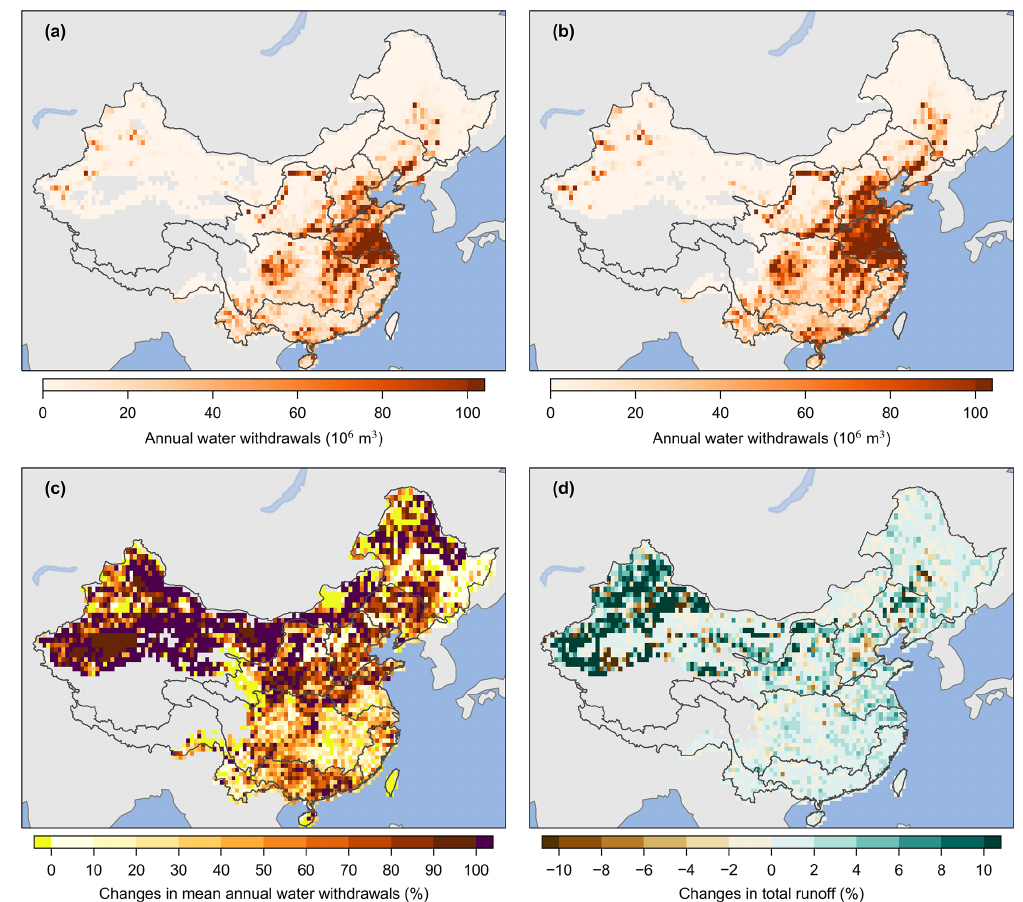
Figure 7. Changes in water withdrawals and total runoff between the two sub-periods. (a) Ensemble medians of mean annual water with- drawals over the 1971–1990 period. (b) Ensemble medians of mean annual water withdrawals over 1991–2010 period. (c) Ensemble medians of the changes in mean annual water withdrawals. (d) Ensemble medians of the changes in mean annual total